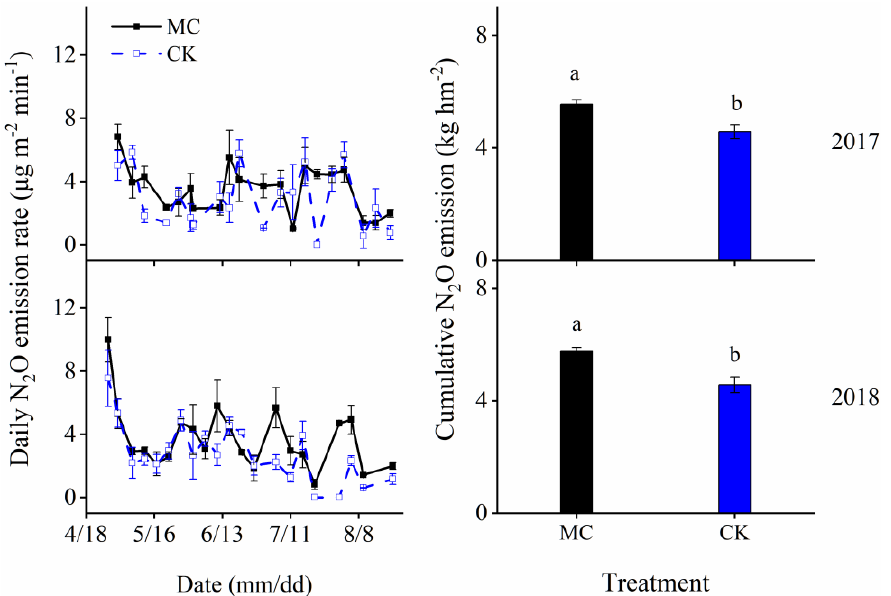
Figure 5. Daily N 2 O emission rates and cumulative N 2 O emissions under the soil with (MC) and without (CK) black plastic film mulching. Different letters above each bar indicate a significant difference between MC and CK at p < 0.05. Values of the columns and standard errors are shown in Table 1. Vertical bars are the standard error of the mean ( n = 3).